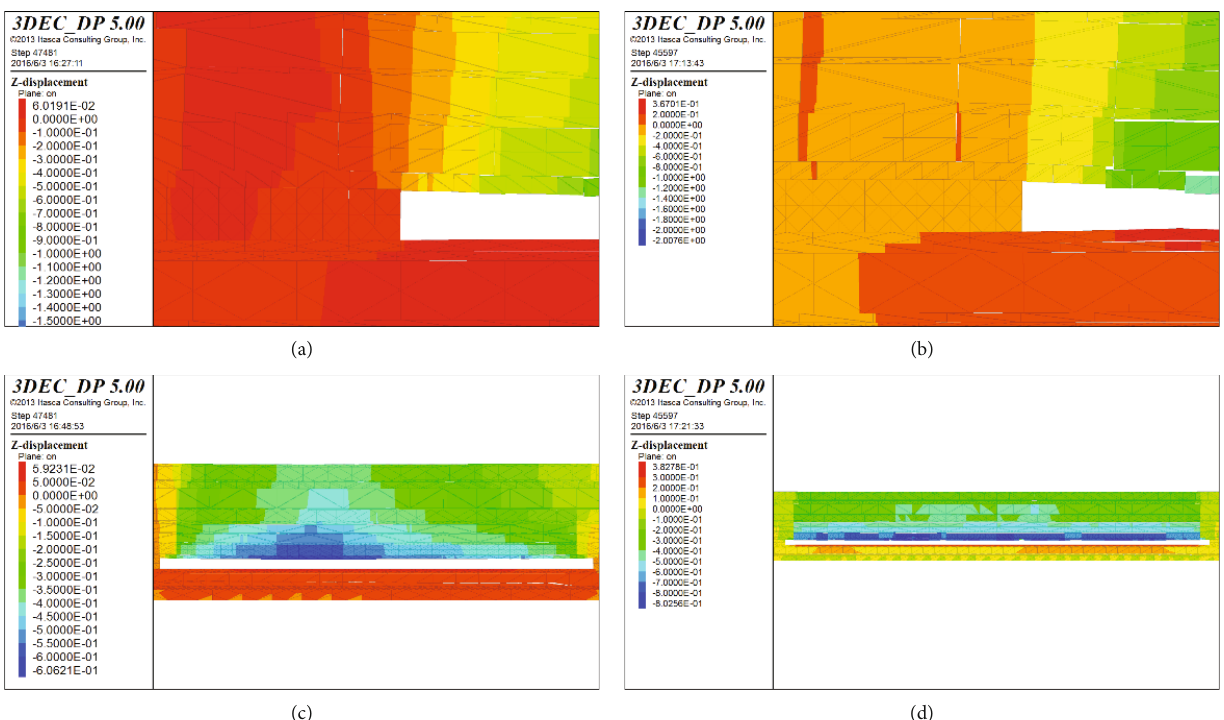
Figure 8: Nephogram of roof strata displacement when advancing to 40 m(unit: m): (a) slice of the 195m working face in advancing direction, (b) slice of the 376m working face in advancing direction, (c) lengthwise slice of the 195m working face, and (d) lengthwise slice of the 376m working face.